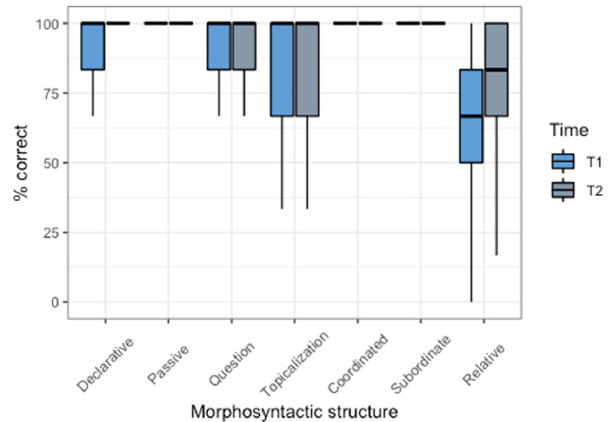
Figure A2. Boxplot of participants’ performance on each structure of the Arabic SRT at T1 and T2. Percentages of correct responses are shown on the y -axis.